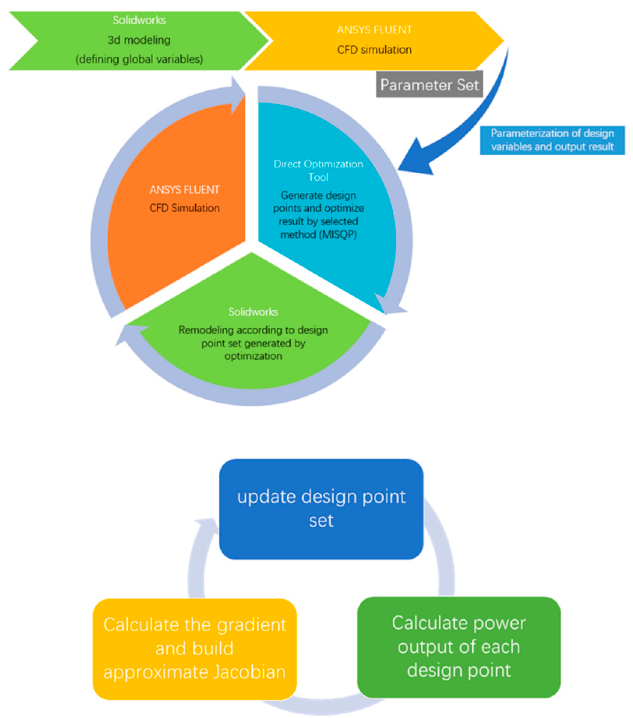
Figure 7. The second optimization framework.